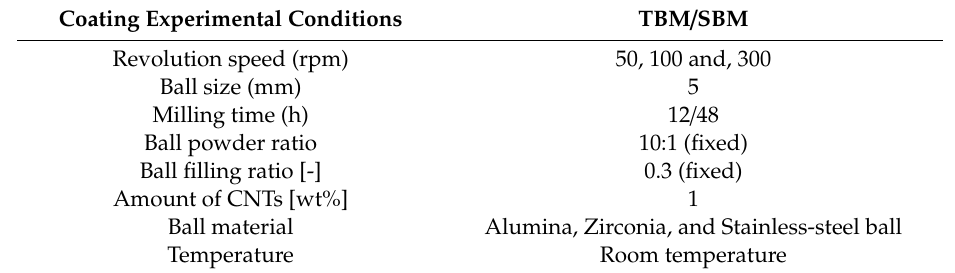
Figure 2. Schematic view of the CNT coating on the metal surface powders by two kinds of ball milling process [20]. Table 1. Experimental conditions for CNT coating on the metal surface by ball milling processes.